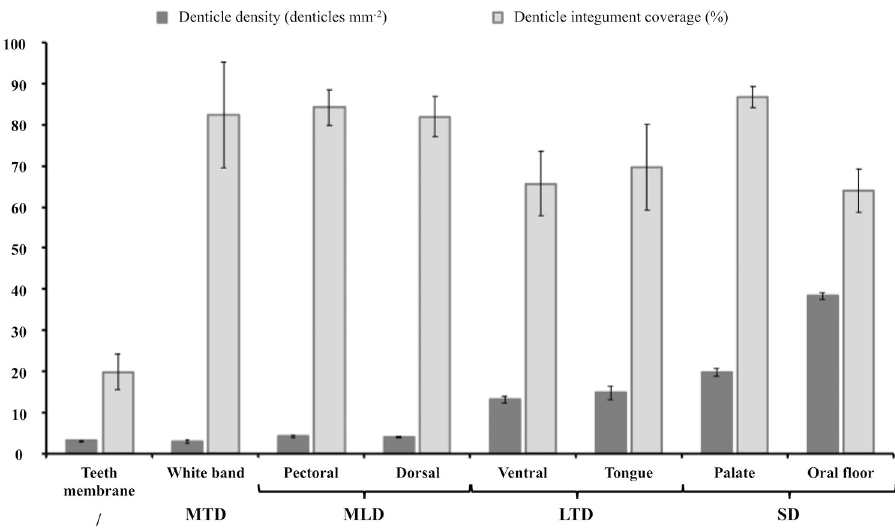
Fig 5. Means of denticle density and integument coverage for each studied M . pelagios skin area. Denticle groups: MTD, massive tabular denticles; MLD, massive lanceolate denticles; LTD, large thin denticules; SD, small denticles with a cusped crown; /, not included in a denticle